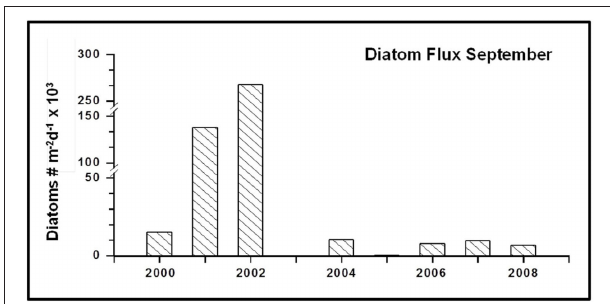
FIGURE 4 | Microscopic counts of diatoms in the sediment trap